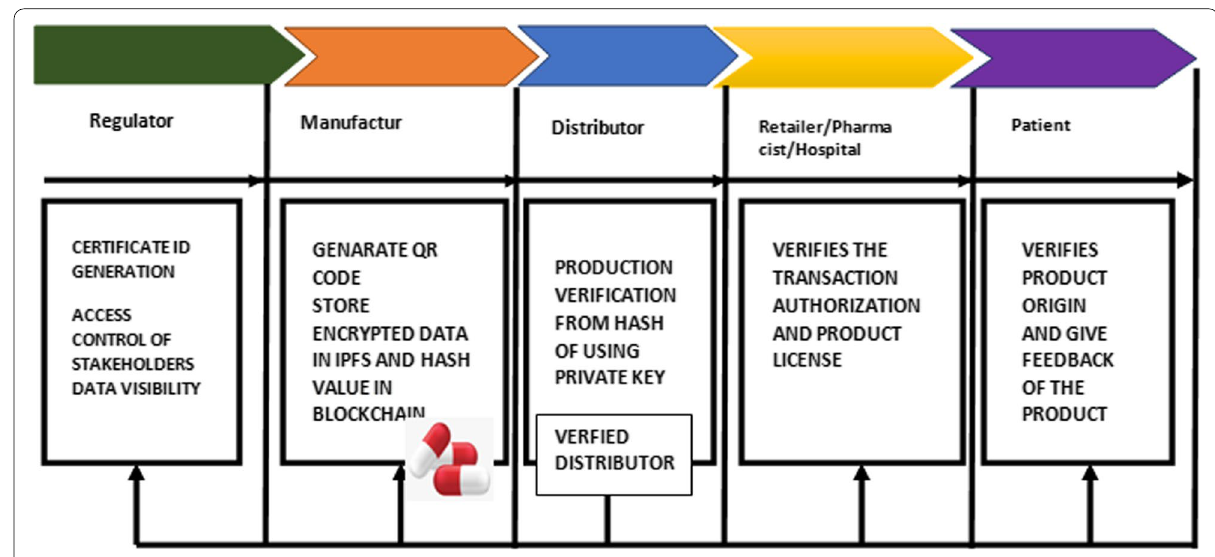
Fig. 6 The Transaction